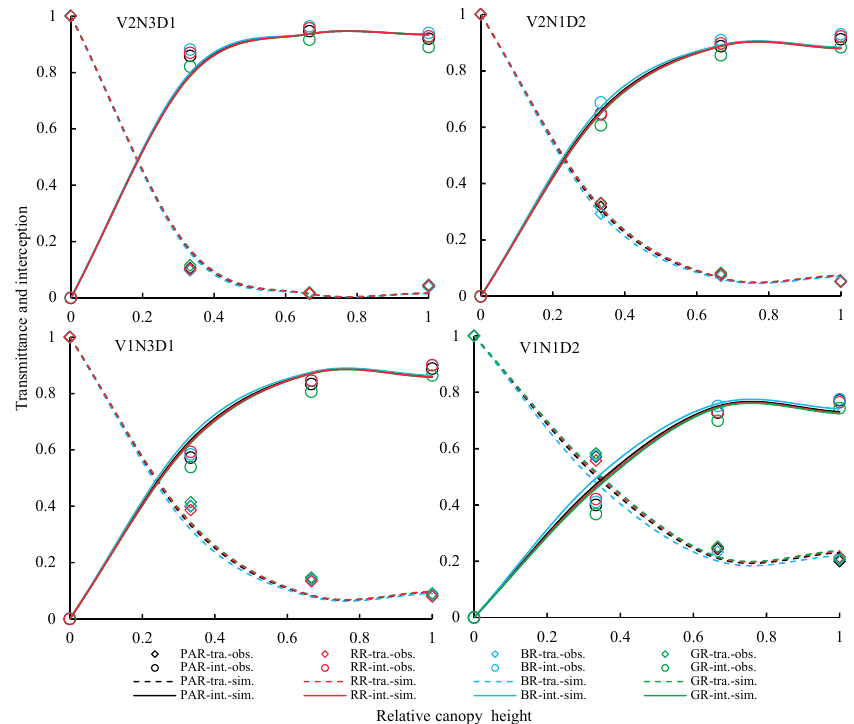
Figure 11. Comparison of simulated and observed radiation transmittance and interception in different relative canopy depths under different nitrogen rates and planting densities for two rice varieties, heading stage; V1, Wuxiangjing14; V2,